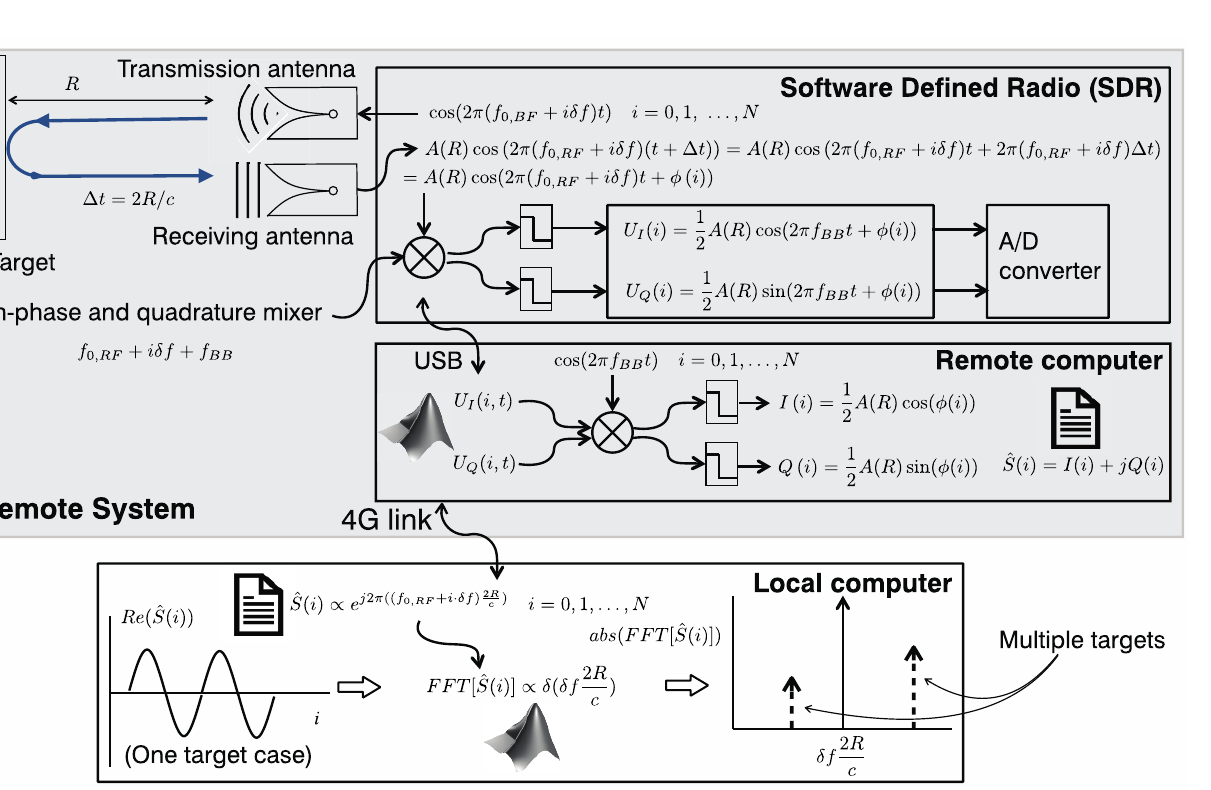
Figure 1. Structure of a stepped-frequency continuous wave (SFCW) radar system. The gray area is the part of the system that is located in the remote location. Software defined radio (SDR) control is performed in C++ from the remote computer and also computes the spectral reflectance and sends it to the local computer. Both computers develop their algorithms using MATLAB ® .